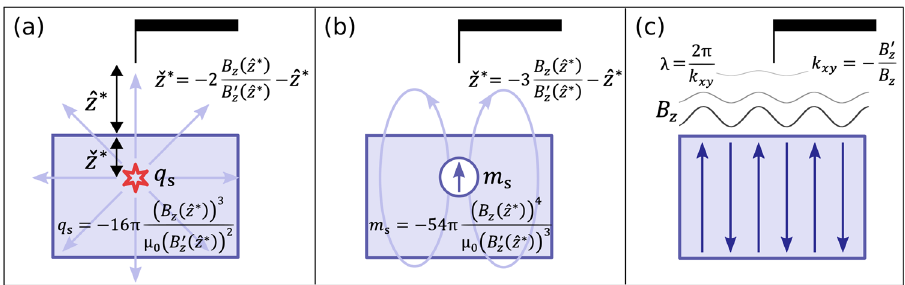
Fig. 3 Potential of a simultaneous B z and B 0 z measurement. Schematic cross-sections of three different probe-sample arrangements and corresponding idealized data evaluation for a single spot magnetic force microscopy (MFM) measurement at a distance ^ z (cid:2) between the position of the tip moment and the sample surface. Simultaneous fi eld B z and fi eld derivative B 0 z measurements allow for a direct estimation of both the vertical position (cid:2) z * and the moment strength q s of buried magnetic point monopoles ( a ) and perpendicular dipoles m s ( b ). In case of periodic stray- fi eld distributions they directly provide its wavenumber k xy ( c